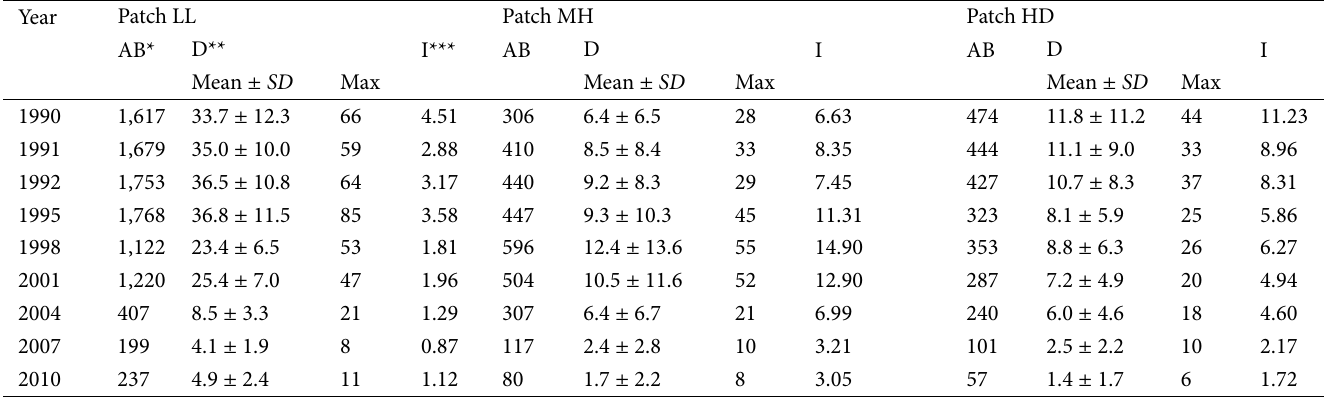
Table 2 Successive changes in abundance, density, and dispersion mode of ramets in the study patches of the Senecio umbrosus population. Patch